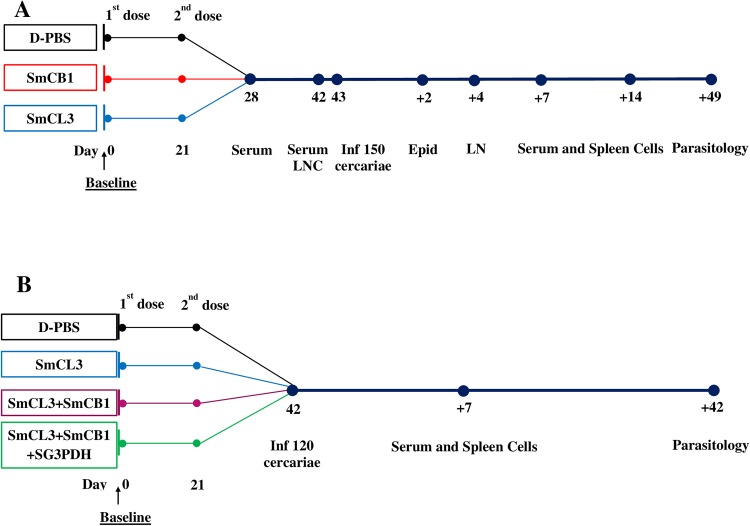
Overview of vaccine schedule using SmCB1 and SmCL3 in mice.Schedule shows regime of vaccine delivery and challenge infection with schistosome cercariae. Time-points of tissue sampling and parasitological analysis are also shown.